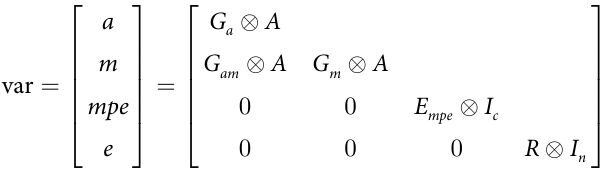
where β represents the fi xed effects (contemporary group as a cross-classi fi ed effect) and cow age at calving (as linear and quadratic effects) as covariates), associated with the observation (records), vector y is the known matrix X and a , m and mpe are the random effects vectors (direct, maternal and maternal permanent environmental effects, respectively) associated with records in y by the incidence matrix Z 1 , Z 2 , and Z 3 , respectively; and e is the residual (co)vari- ance. For this model, it was assumed that: